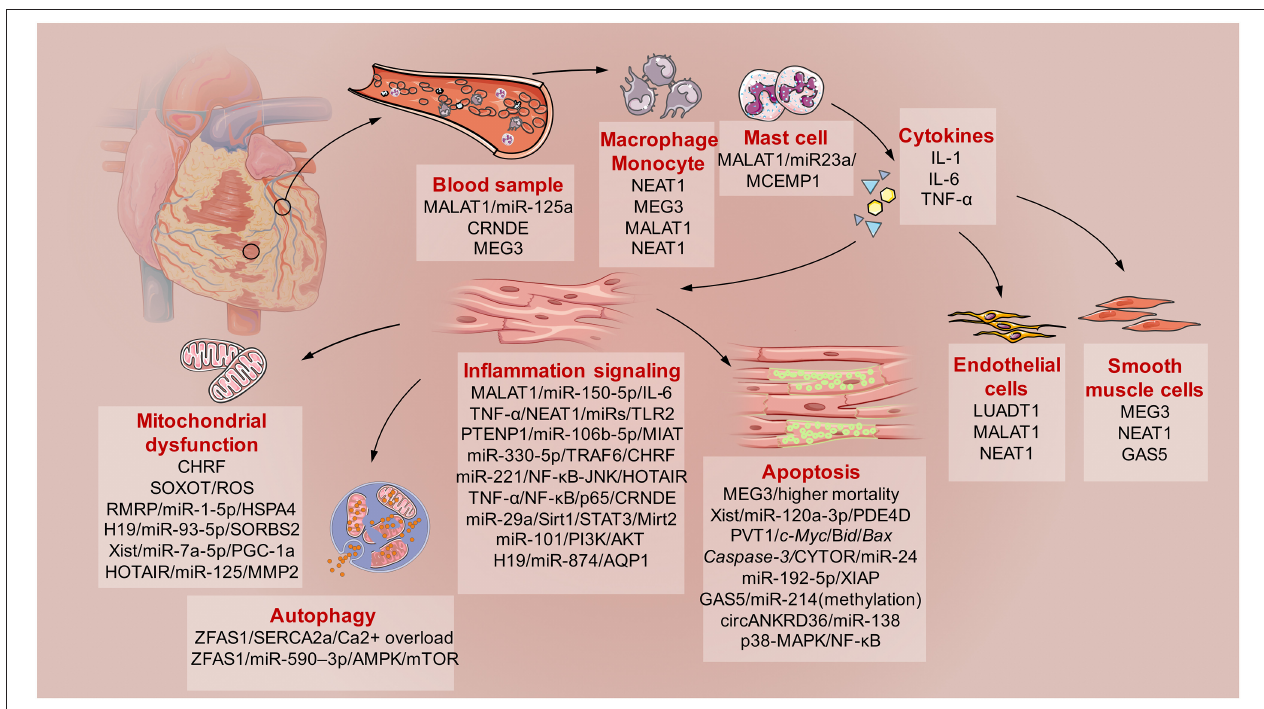
FIGURE 2 | The schematic diagram describes the involved lncRNAs in sepsis induced cardiac dysfunction (SICD). Generally, current evidences demonstrated some lncRNAs served as biomarkers for SCID. Then, monocytes, macrophage, and mast cells would be activated with kinds of cytokines secretion. After that, immune responses of cardiomyocytes would lead to mitochondrial dysfunction, apoptosis and autophagy under the regulation of specific lncRNAs. Besides, lncRNAs also participates in the regulation of endothelial cells and smooth muscle cells during